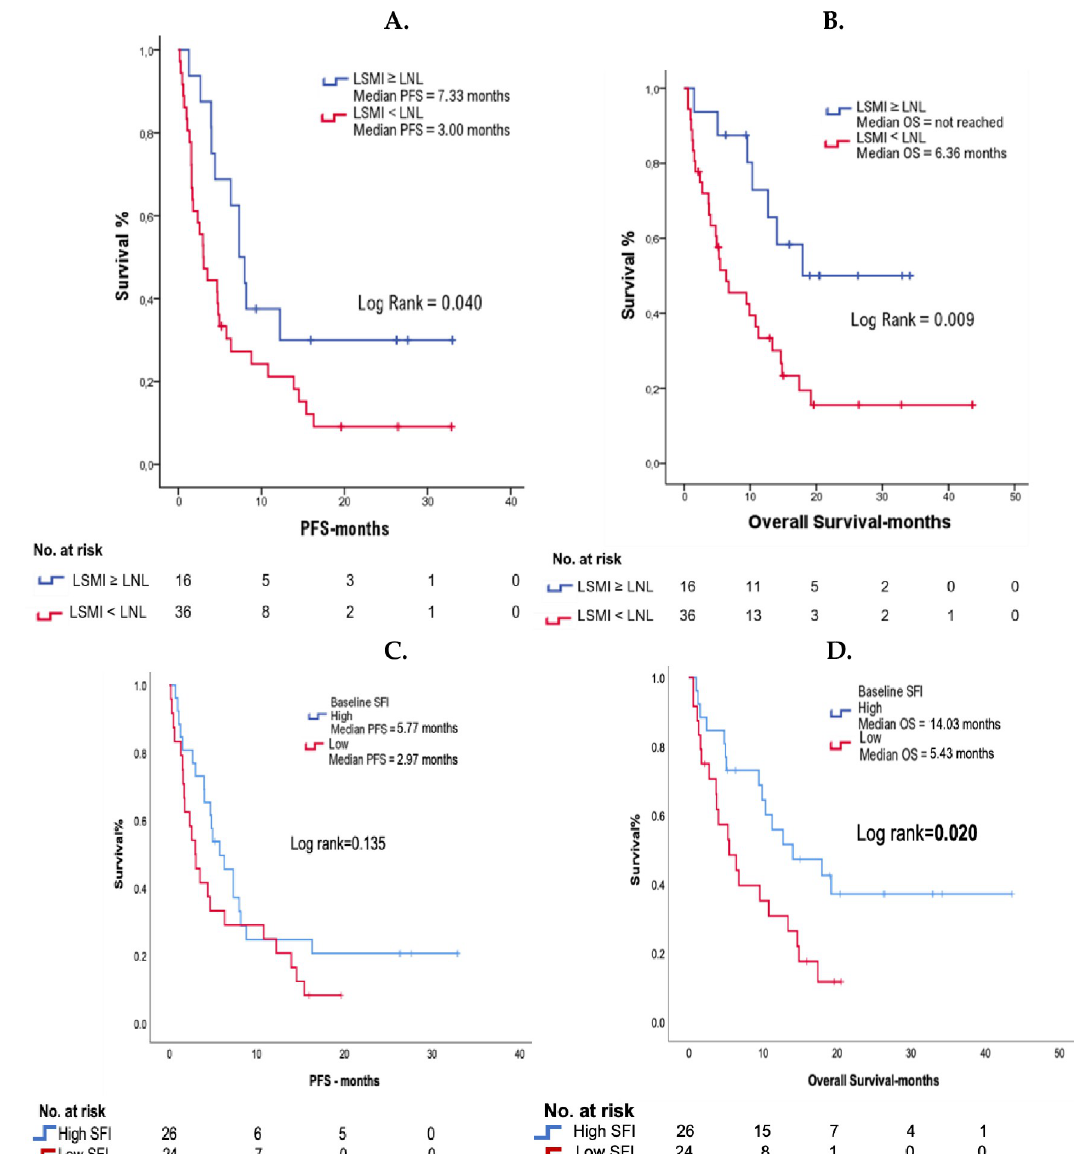
Fig 3. Kaplan-Meier curves demonstrating the effect of A. Baseline � 1 LSMI � 2 values on PFS B. Baseline LSMI values on OS C. Baseline SFI � 3 values on PFS D. Baseline SFI values on OS. Abbreviations: LSMI = Lumbar skeletal muscle index (At the level of 3 rd lumbar vertebra); SFI = Subcutaneous Fat Index (At the level of 3 rd lumbar vertebra); OS = Overall survival; PFS = Progression free survival. � 1 Baseline: At the beginning of immunotherapy with PD-1/PD-L1 inhibitors. � 2 LNL: Lower normal limit, 55 cm 2 /m 2 for males and 39 cm 2 /m 2 for females. � 3 High and low classification for SFI represents above and below gender specific median value, respectively.